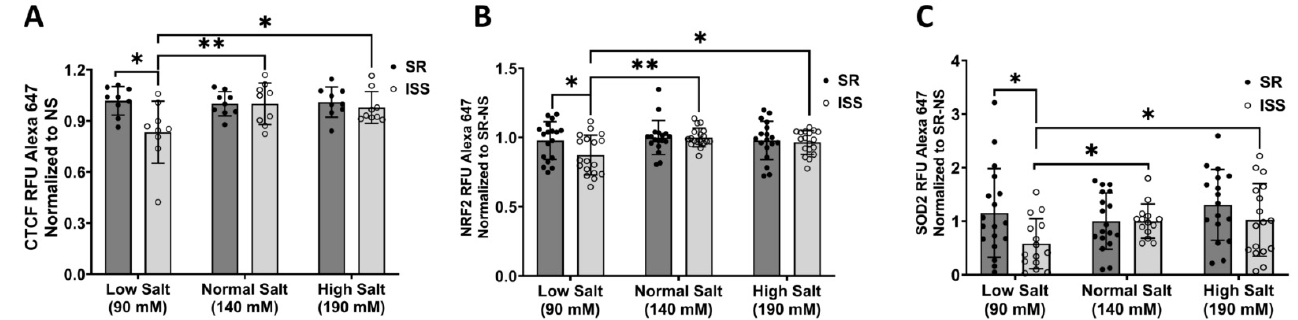
Figure 3. CTCF, NRF2 and SOD expression under salt treatment by In-Cell Western. SR and ISS cells were treated with low salt (90 mM), normal salt (140 mM) and high salt (190 mM) overnight. ( A ) CCCTC-binding factor (CTCF) expression decreased only in uRPTCs from ISS subjects incubated under low salt concentration (SR low salt, 1.02 ± 0.03 vs. ISS low salt, 0.83 ± 0.06; ISS low salt vs. ISS normal salt, 1 ± 0.04; ISS low salt vs. ISS high salt, 0.98 ± 0.03, * p < 0.05, ** p < 0.01, n = 9/group, two-way ANOVA, Holm-Sidak post hoc test). ( B ) Nuclear factor erythroid 2-related factor 2 (NRF2) expression significantly decreased only in ISS uRPTCs under low salt concentration (SR low salt, 0.98 ± 0.03; vs. ISS low salt, 0.87 ± 0.03; * p < 0.05, n = 18/group; ISS low salt vs. ISS normal salt, 1 ± 0.02; ISS low salt vs. ISS high salt, 0.96 ± 0.02, * p < 0.05, ** p < 0.01, n = 18/group, Two-way ANOVA, Holm-Sidak post hoc test). ( C ) SOD2 was significantly decreased only in ISS uRPTCs under low salt concentration (SR low salt, 1.15 ± 0.19; vs. ISS low salt, 0.58 ± 0.11; ISS low salt vs. normal salt 1 ± 0.08; ISS low salt vs. ISS high salt 1.02 ± 0.16, * p < 0.05, n = 18/group, ISS low salt vs. ISS normal salt, one-way ANOVA, Holm-Sidak post hoc test). ISS = inverse salt-sensitive; SR =